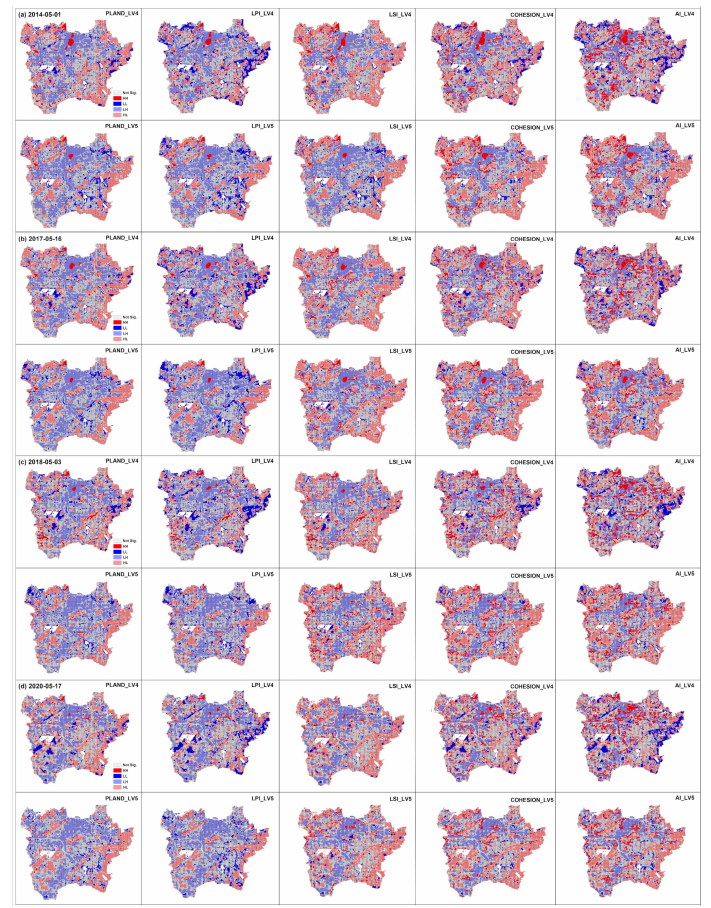
Figure 8. Local Indications of Spatial Association (LISA) cluster maps between landscape metrics of the vegetation fraction (VFLM; LV4 and LV5) and land surface temperature (LST): ( a ) 1 May 2014; ( b ) 16 May 2017; ( c ) 3 May 2018; ( d ) 17 May 2020 (HH: high VFLM and high LST; LL: low VFLM and low LST; LH: low VFLM and high LST; HL: high VFLM and low